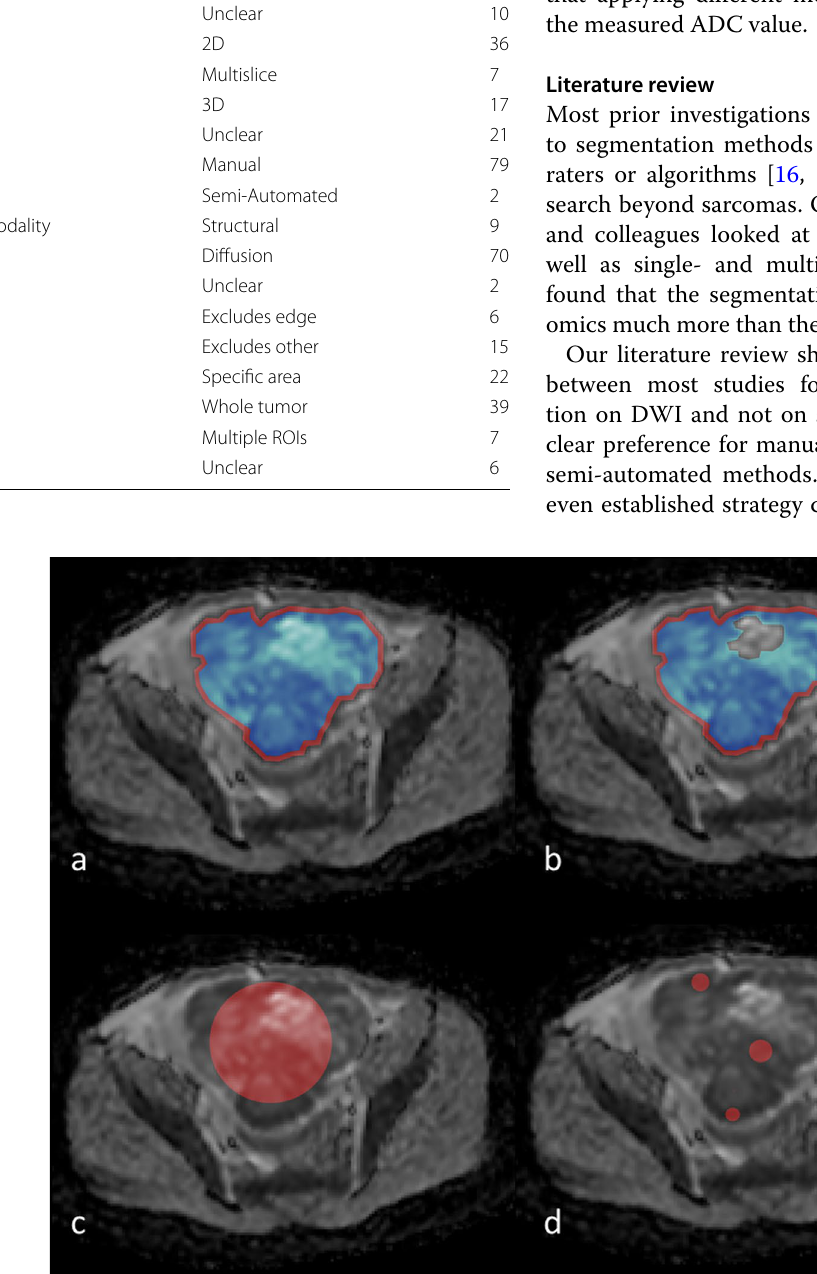
Fig. 2 Illustrative example of diffusion-weighted image with regions of interest (ROIs) of six commonly used segmentation areas highlighted. a ‘Inside’ strategy, blue area. ‘Whole tumor’ strategy, red d ‘Max DWI circles’